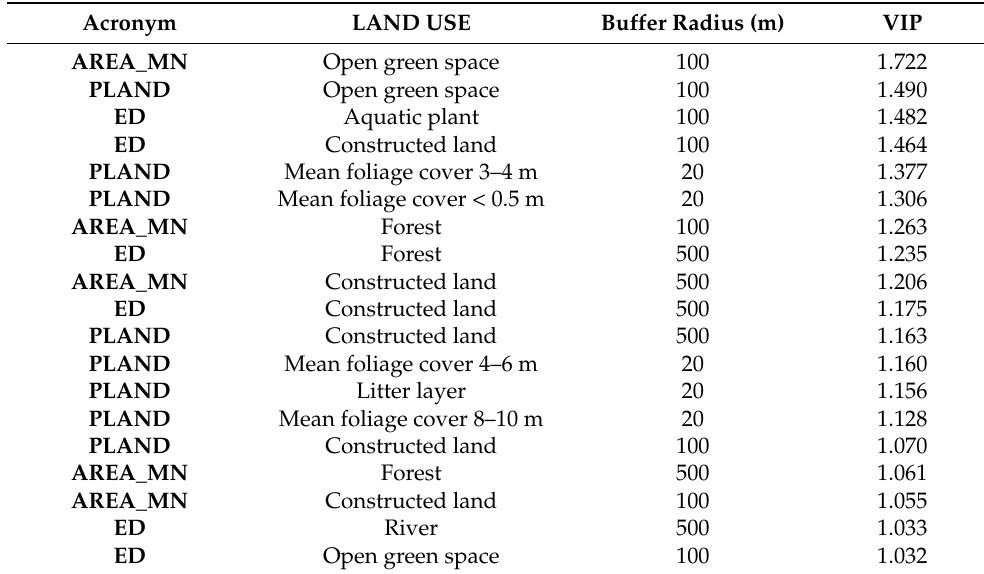
Table A3. The PLSR analysis utilizes richness as the response variable and landscape- and patch-level variables as the explanatory variables. The explanatory variables with VIP ≥ 1 were selected (sorted by VIP score value).